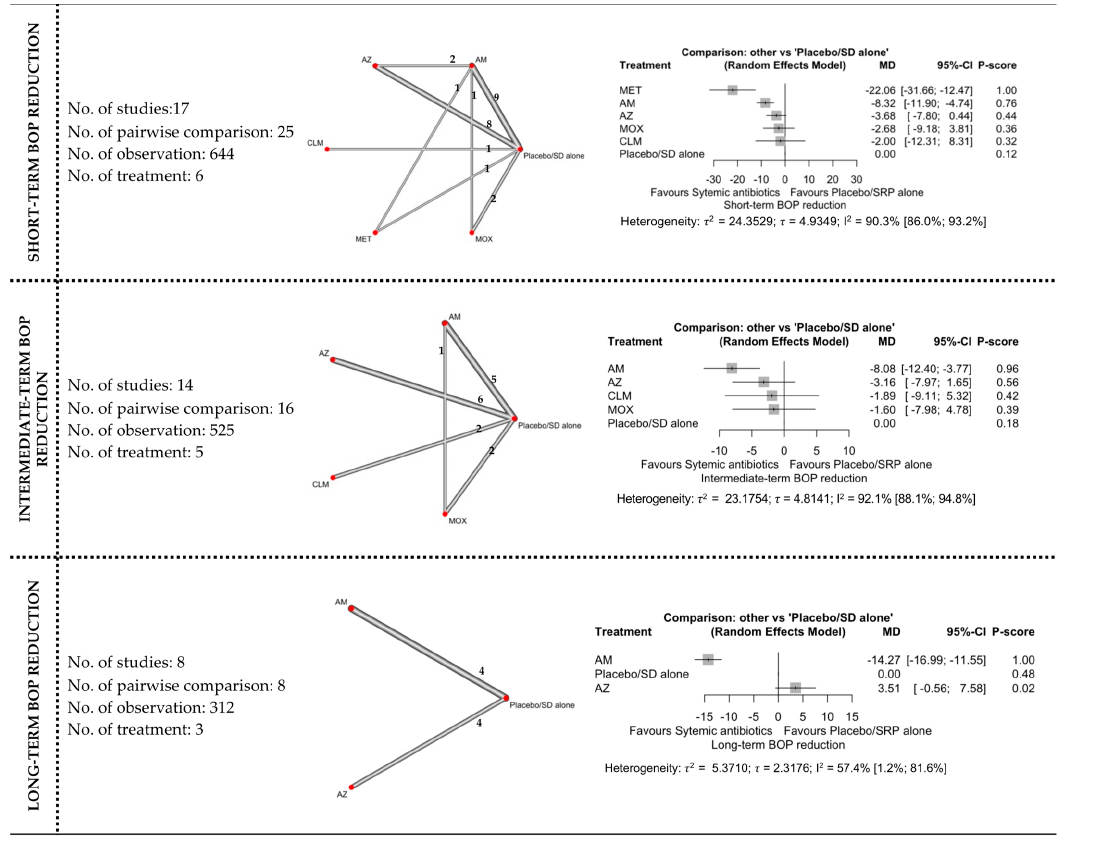
Figure 5. The network and forest plots of the network meta-analysis for BOP reduction. AM: amoxycillin + metronidazole; AZ: azithromycin; CEF: cefixime; CLM: clarithromycin; DOX: